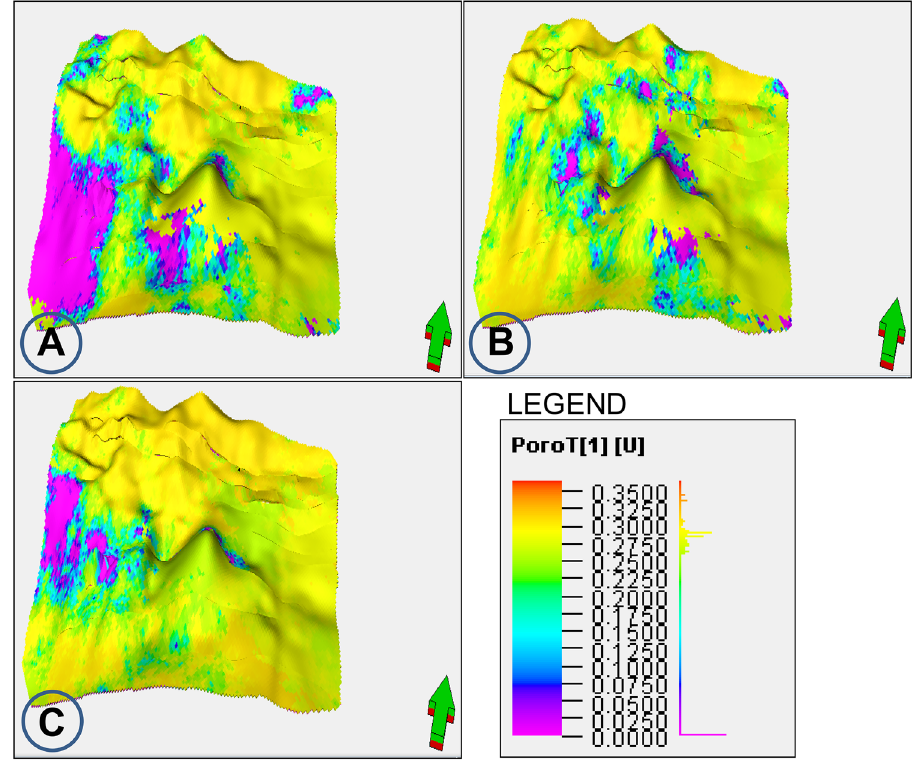
Fig. 15 Equiprobable realiza- tions of permeability from K300